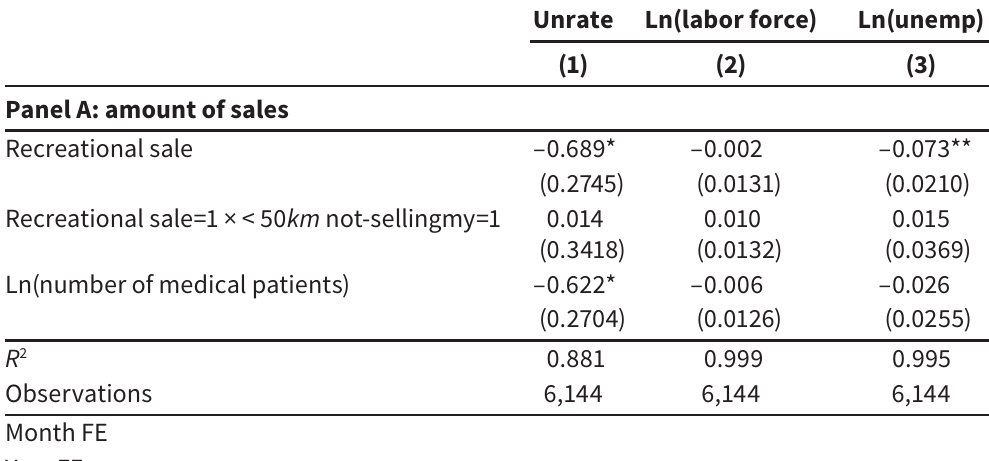
The effect of recreational dispensary entry and sales on the Unemployment Rate (Unrate), Ln(labor force), and Ln(unemployed) – regression analysis Unrate Ln(labor force) Panel A: amount of